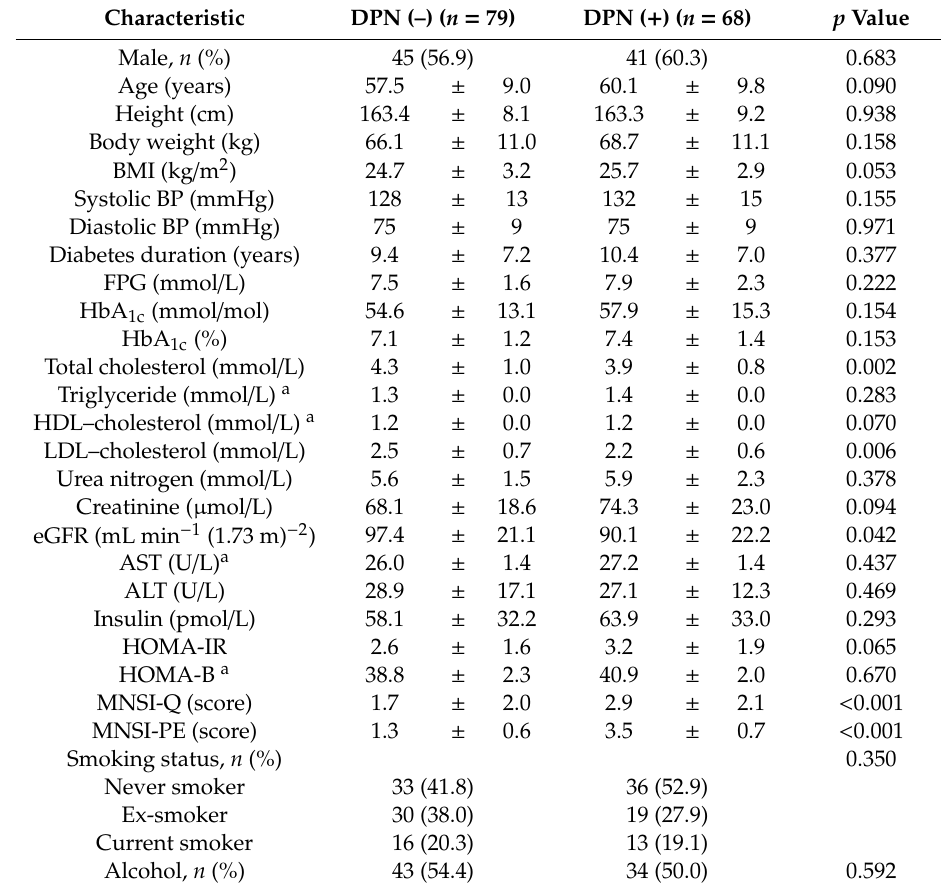
Table 1. Clinical and biochemical data of individuals according to the presence of diabetic peripheral neuropathy